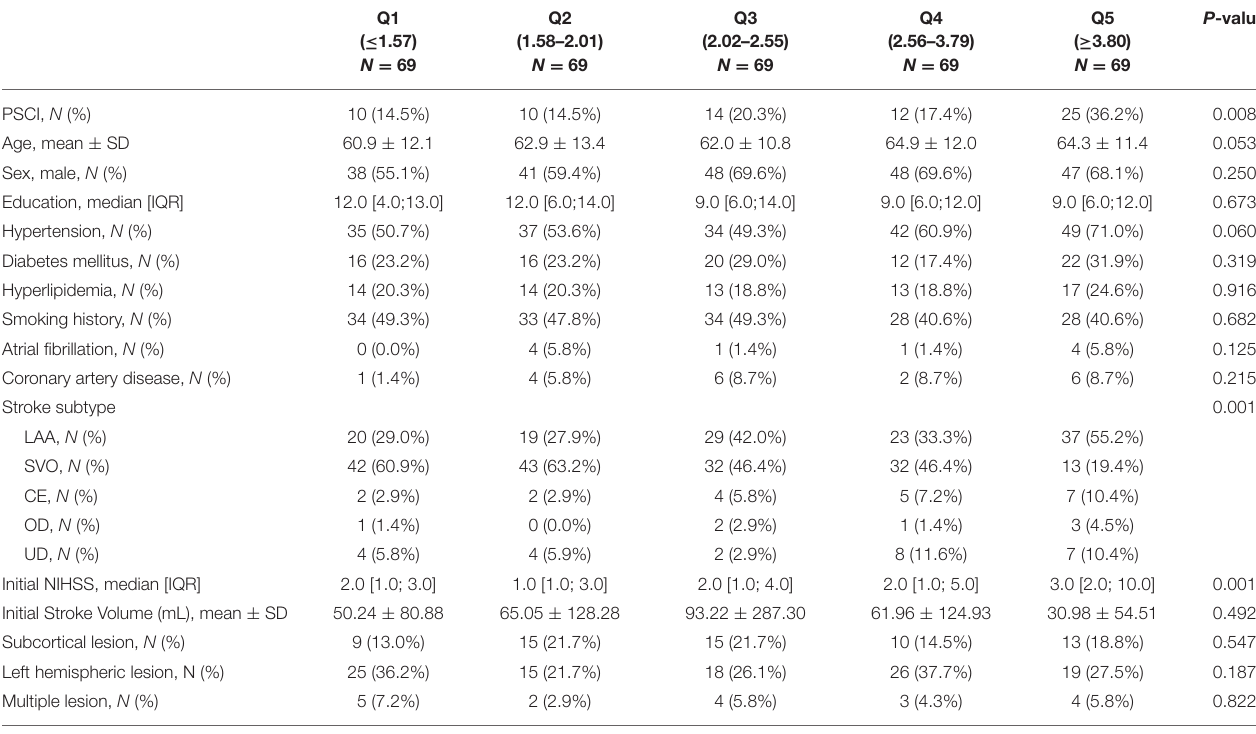
TABLE 2 | Baseline characteristics according to the quintile of NLR.